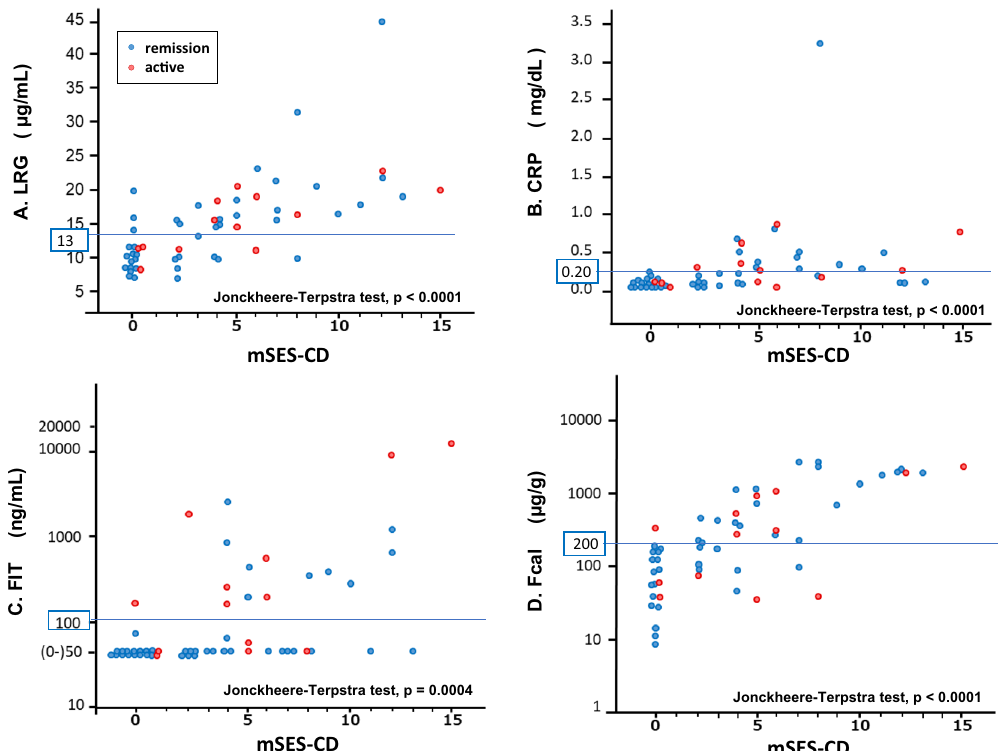
Figure 3. Correlation between the serum/fecal biomarkers and mSES-CD in CD patients. ( A ) LRG, ( B ) CRP, ( C ) FIT, ( D ) Fcal. mSES-CD modified simple endoscopic score for Crohn’s disease, CD Crohn’s disease, LRG leucine-rich alpha-2 glycoprotein, CRP C-reactive protein, FIT fecal immunochemical test, Fcal fecal calprotectin. The red dots indicate the values of patients with active stage and the blue dots indicate the values of patients with remission stage. The specimens with a hemoglobin concentration within this range (0–50 ng/ mL) were handled as category, because FIT is not accurate for measuring hemoglobin concentrations of < 50 ng/ mL. Parallel blue lines showed the cutoff values of serum/fecal biomarkers in this study (LRG: 13.0 µg/mL, CRP: 0.20 mg/dL, FIT: 100 ng/mL, and Fcal: 200 µg/g).